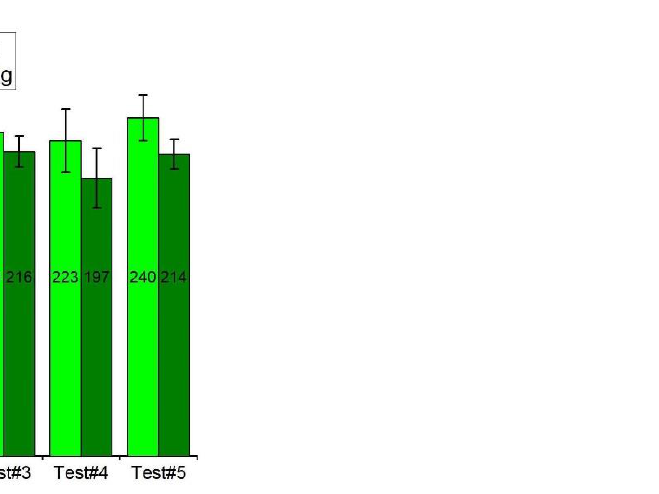
Figure 11. Change in microhardness of samples after annealing to remove thermal vacancies, based on [12].